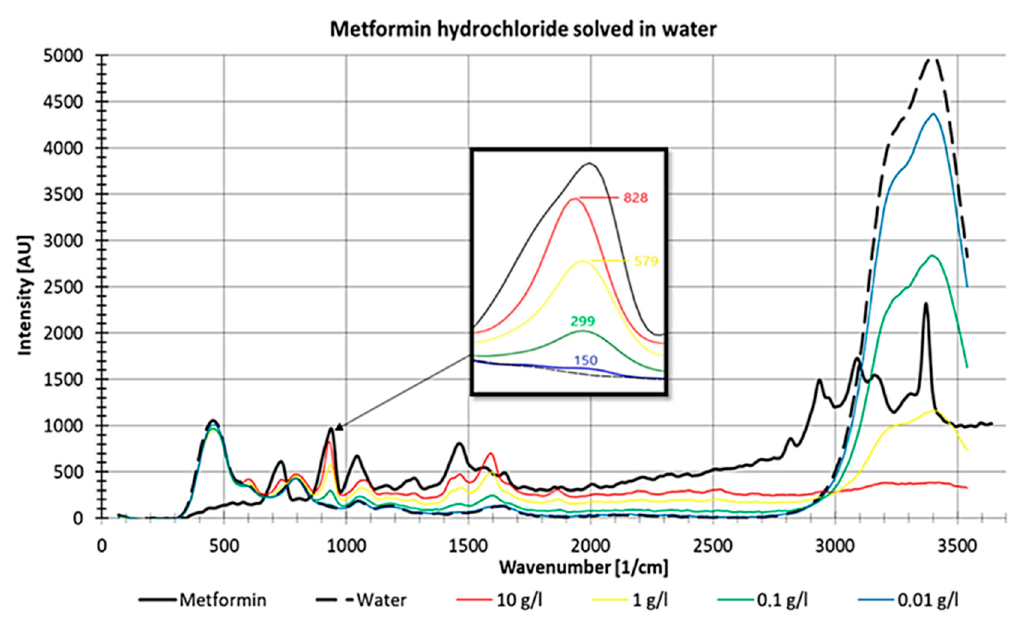
Figure 12. Raman measurements of pure metformin and different concentrations of metformin hydrochloride dissolved in water, measured in a fused silica cuvette with detail enlargement.